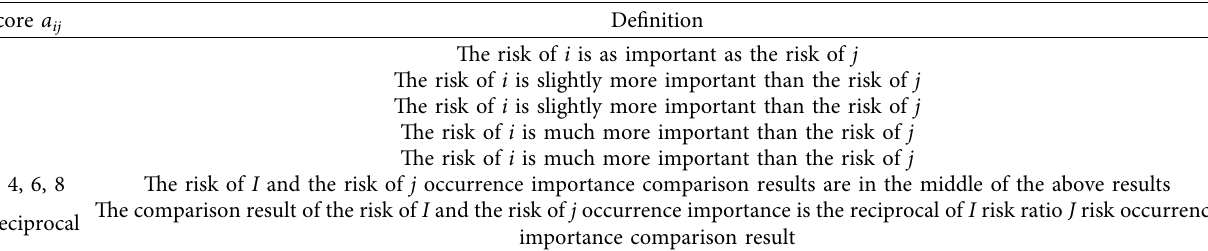
Table 1: Risk weight (scale) evaluation score table.